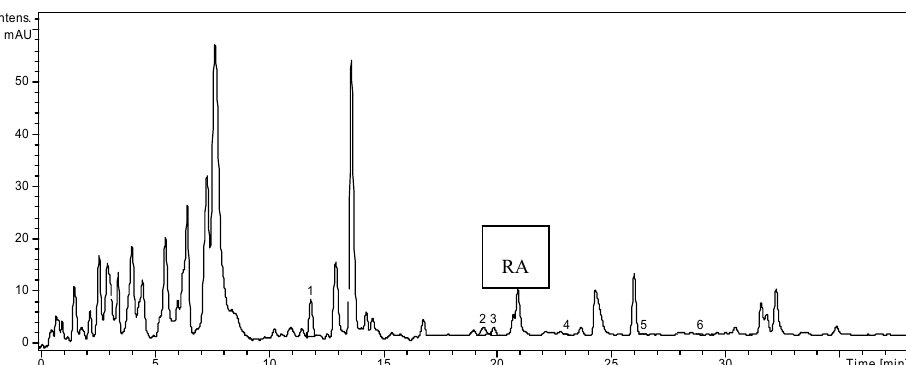
Figure 1. HPLC chromatogram of H. officinalis sample.